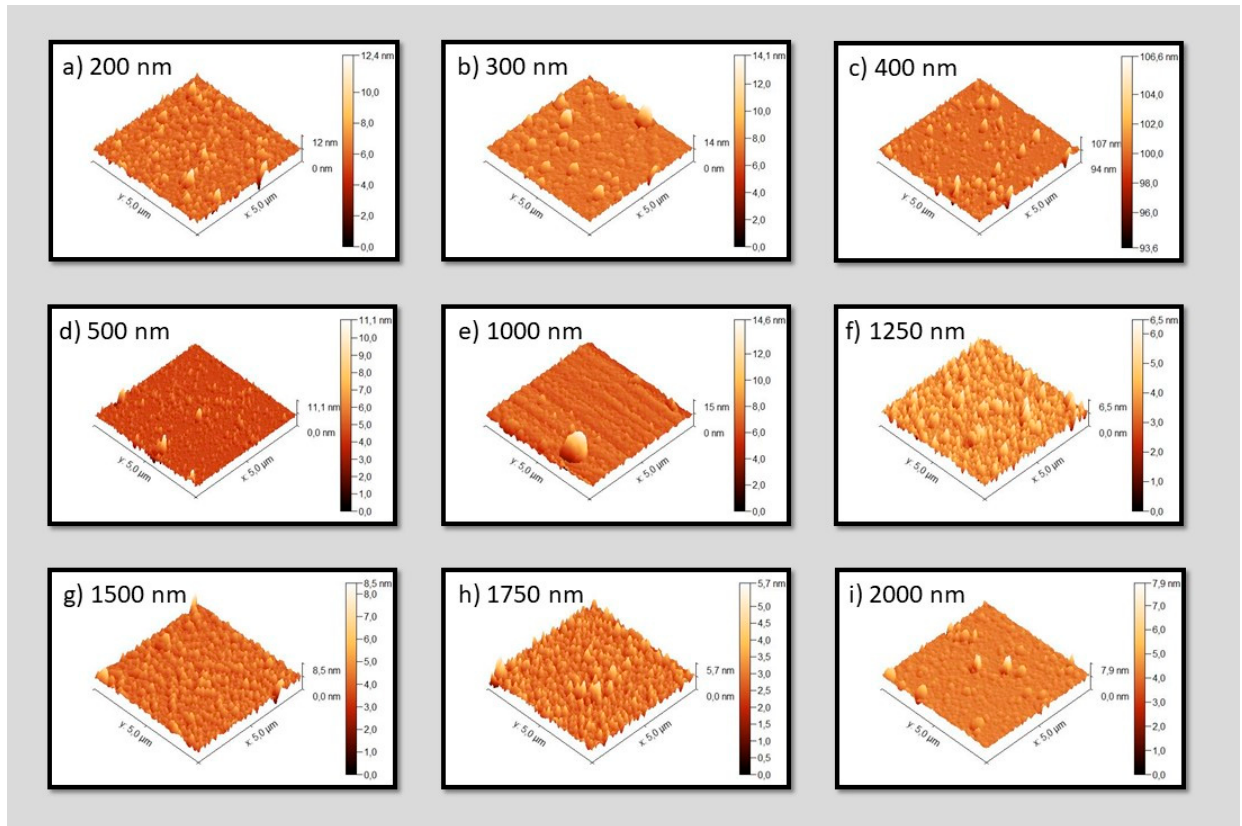
Figure 4. AFM 3D-images for PC samples coated with thick a-C:H layers from 200 nm ( a ) to 2000 nm ( i ).